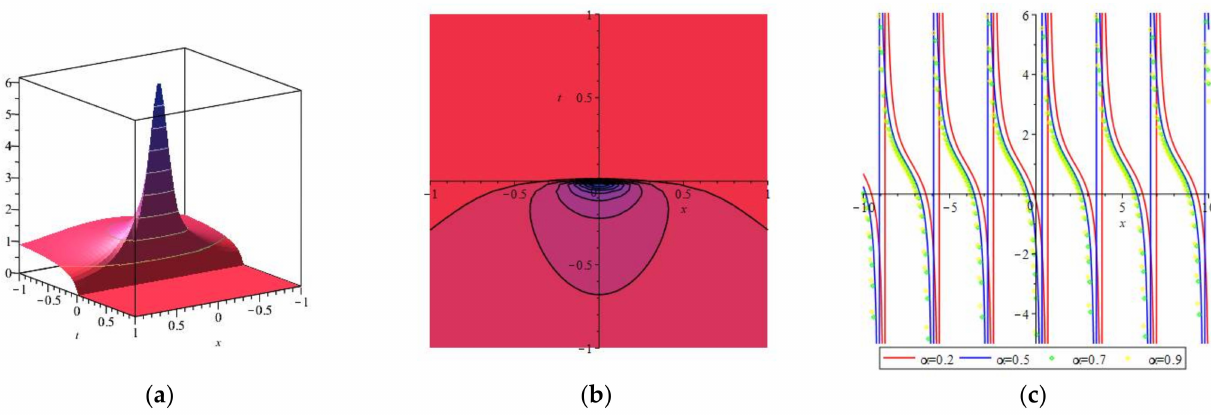
Figure 8. The graphical representation of the solution λ 15 ( χ ) : ( a ) 3D shape, ( b ) contour plot, and ( c ) 2D graph.